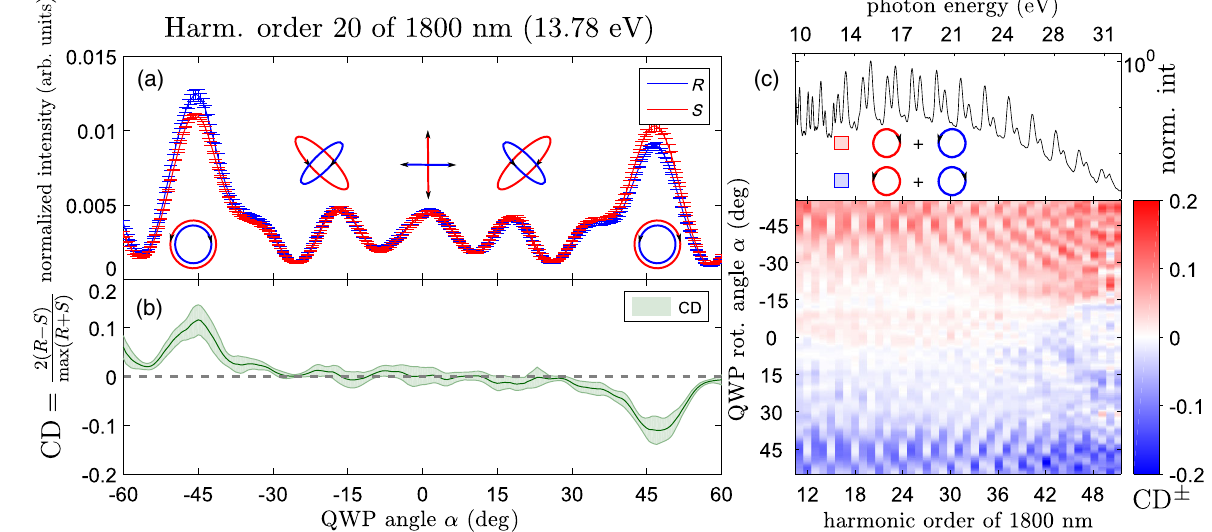
FIG. 1. Circular dichroism measurement using the bicircular scheme. (a) HHG yields for harmonic 20 of R - and S -MOX as a function of the QWP rotation angle. A moving average with a span of 5 data points was applied on the measured signal. The insets show Lissajous representations of the electric component of the driving laser fields. (b) Ellipticity-dependent differential circular dichroism signal CD ð 20 ω ; α Þ . (c) Top: Spectrum of R -MOX recorded for the setting α ¼ − 45 °; bottom: spectrogram showing the CD as a function of the QWP angle and the photon energy. The colors encode the sign of the CD. The intensities are I ω ∼ 3 × 10 13 W = cm 2 and I ∼ 1 . 1 × 10 13 W = cm 2 . The error bars in (a) represent 2 standard deviations of the measured 2 ω